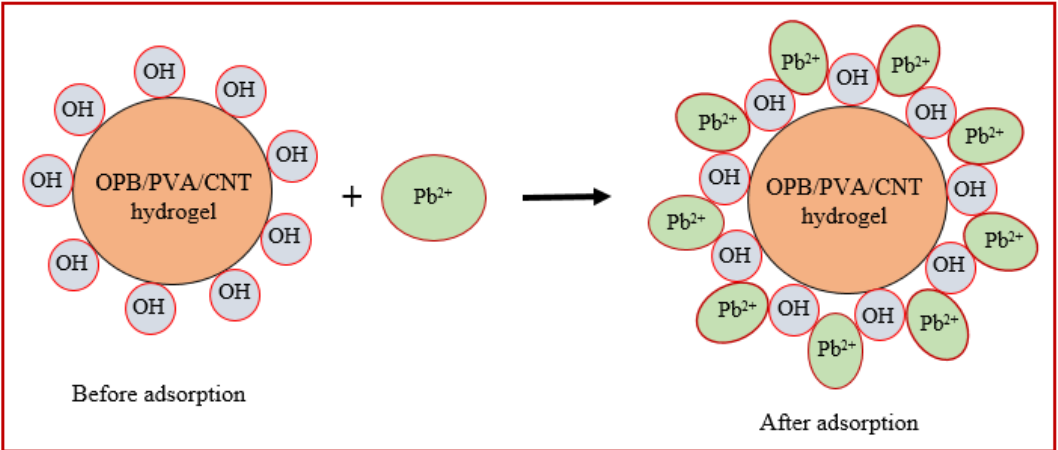
Figure 15. The proposed adsorption mechanism of Pb(II) onto the OPB / MWCNTs reinforced PVA hydrogel composite.